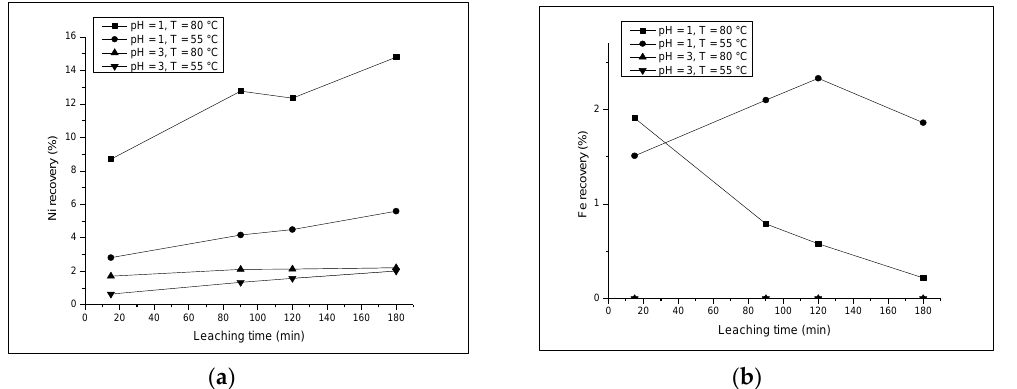
Figure 2 . X-ray diffraction analysis of raw limonite ore, roasted ore and residue after leaching.